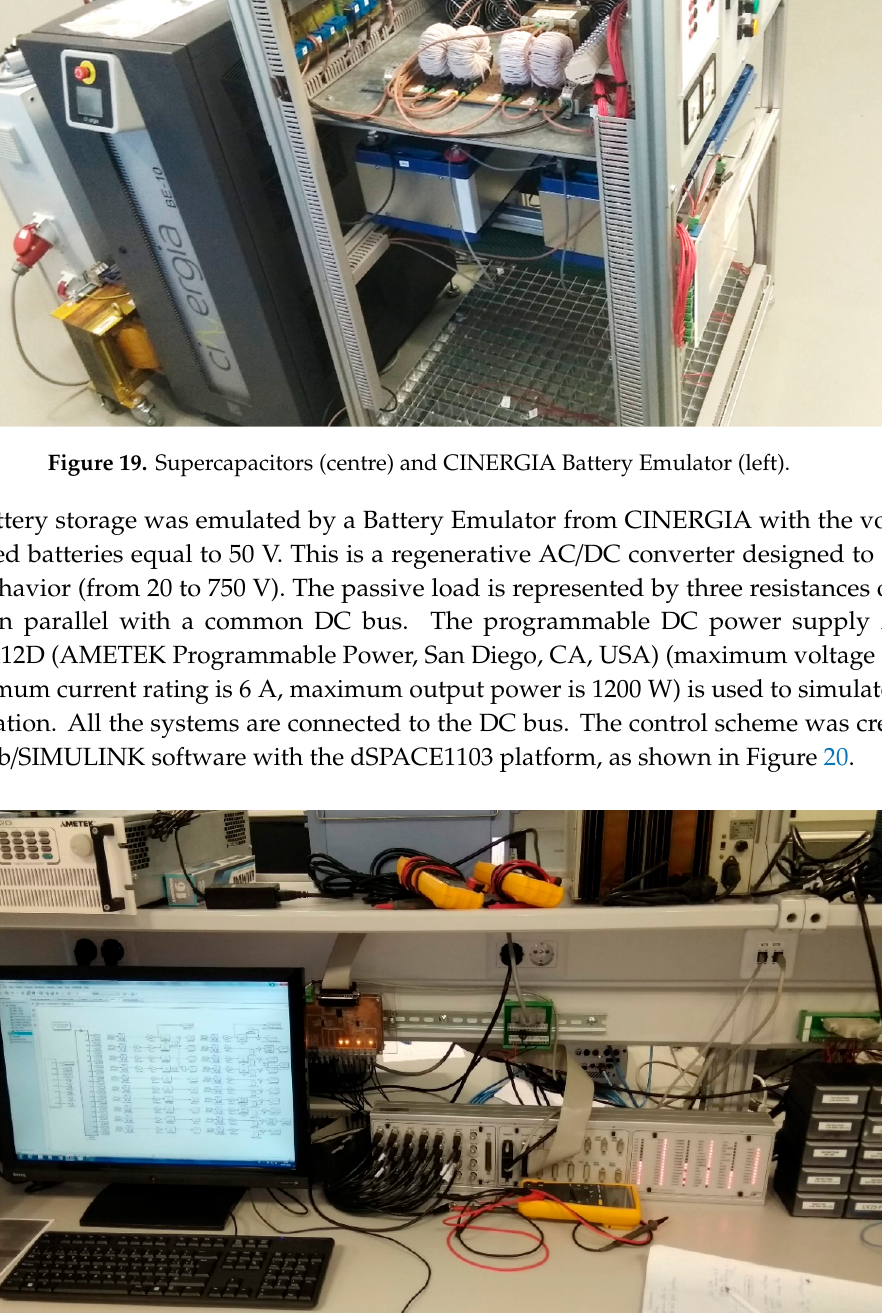
Figure 18. Battery and supercapacitor storage system DC/DC converters.